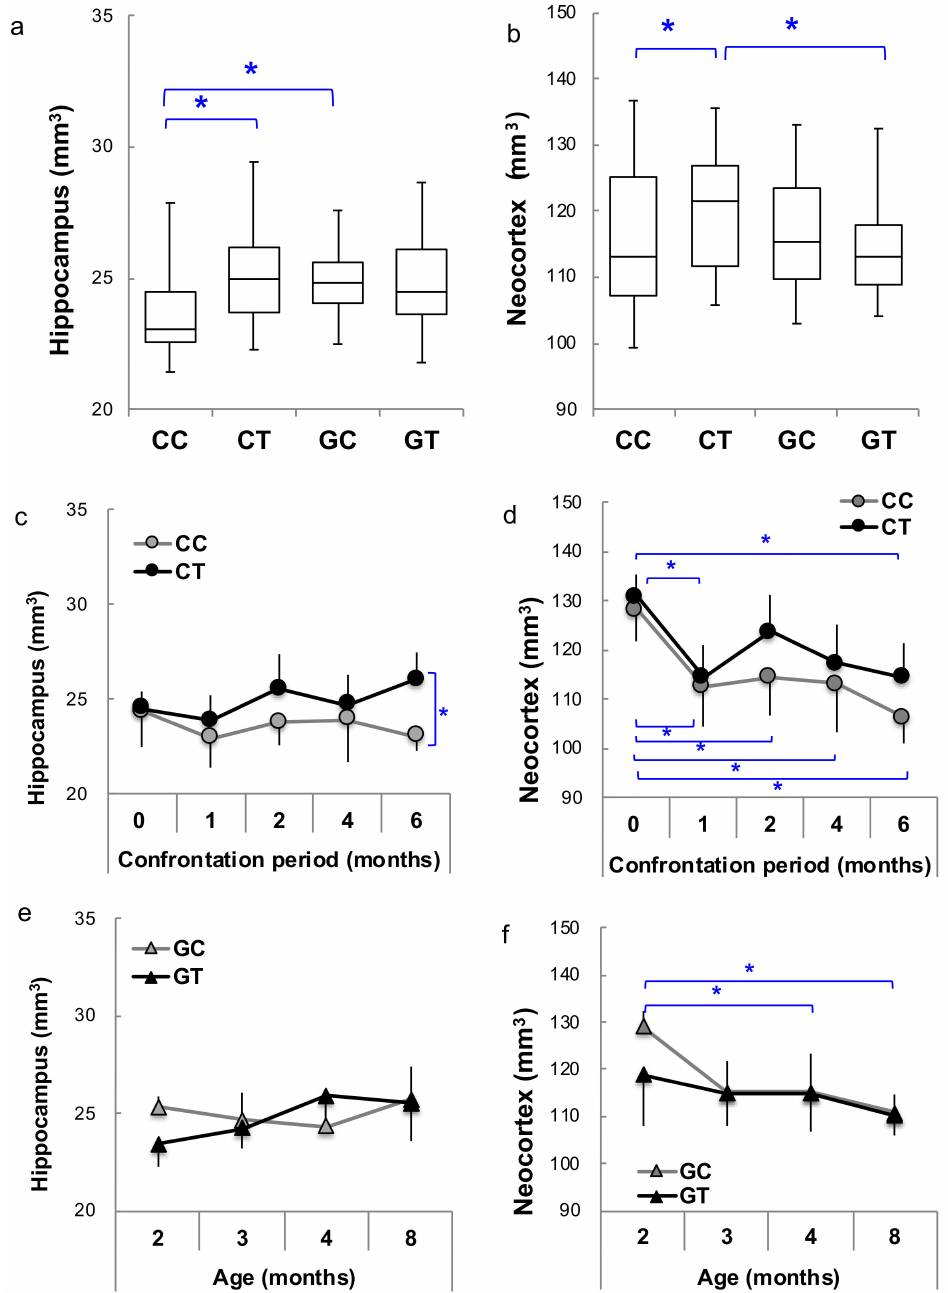
Figure 3. The brain volume of SAMP10 mice. Boxplot of the volumes of brain sections in the hippocampus ( a ) and neocortex ( b ) were compared among the four groups (CC, CT, GC and GT) without distinguishing age ( n = 122, *; p < 0.05). The time-course of hippocampus and neocortex were compared between CC and CT ( c , d ) and between GC and GT ( e , f ) ( n = 3–12; *, p <